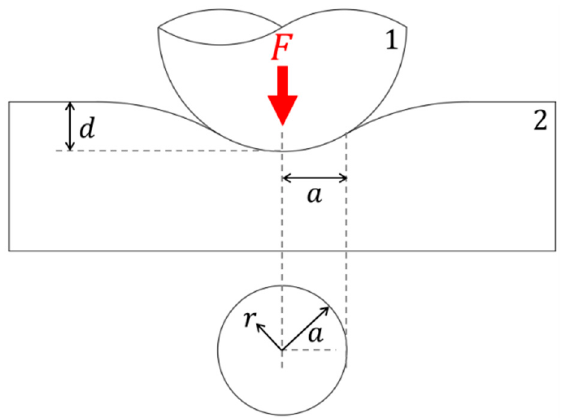
Figure 5. Schematic diagram of the contact between an elastic sphere and sheet.